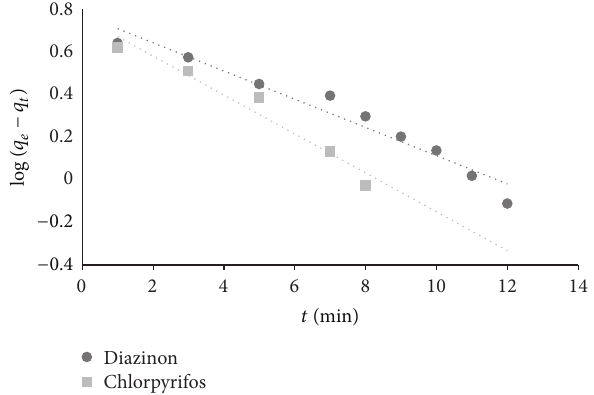
Figure 4: Effect of initial concentration on removal percentage of diazinon and chlorpyrifos by TNP.